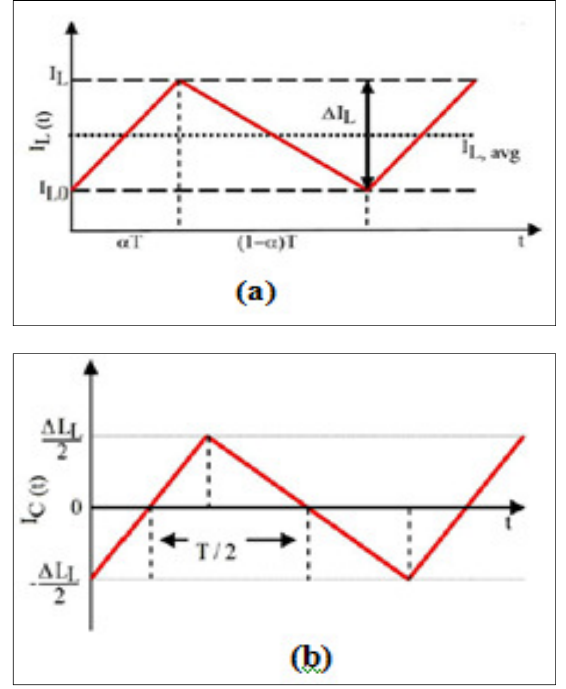
are shown in fig. 9[18].